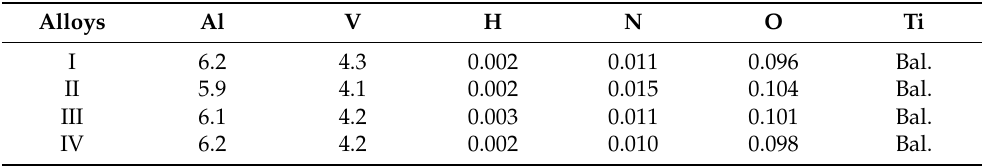
Table 2. Measured chemical compositions (wt.%) of the Ti-6Al-4V. Alloys